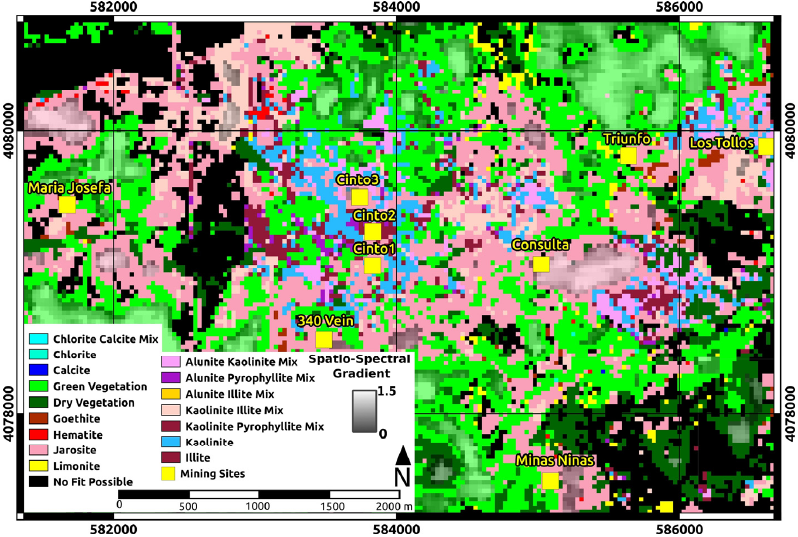
Figure 12. EnGeoMAP 2.0 best fit material map, using sensor dependent absorption depth thresholding, with a semi-transparent overlay of the spatio-spectral gradient using the entries of the USGS digital spectral library [12]. Linear combinations of their entries labeled with as “Mix” follow the suggested endmember combinations of Bedini et al. , 2009